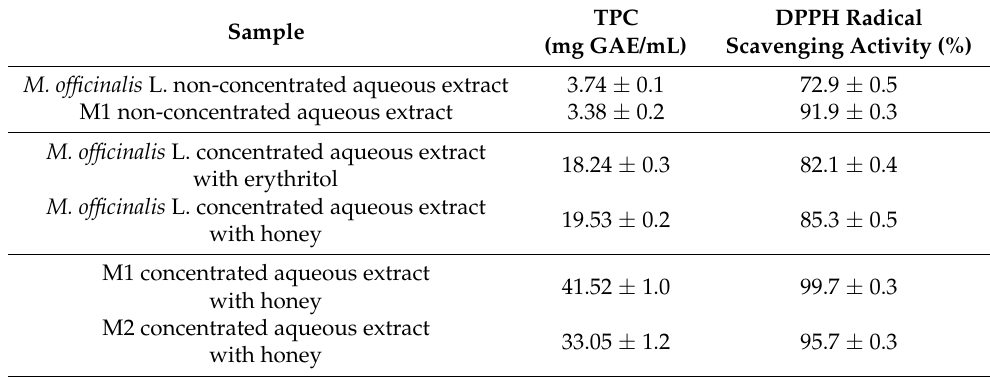
Table 1. Total phenolic content (TPC) and DPPH radical scavenging activity of medicinal aromatic plant (MAP) concentrated aqueous extracts in the presence of erythritol or honey. Sample